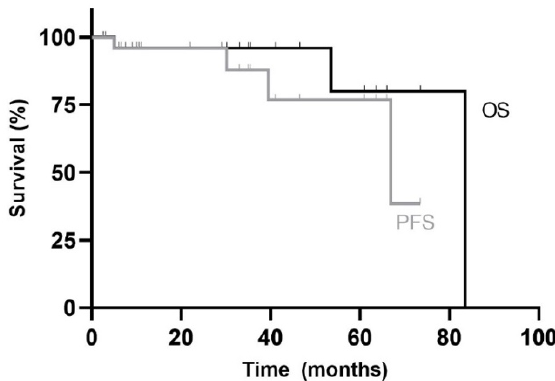
Figure 2. Kaplan–Meier overall survival (OS) and progress-free survival (PFS) curves for adult patients in the study. Median follow-up duration was 26 months (range: 3 months to 7 years).